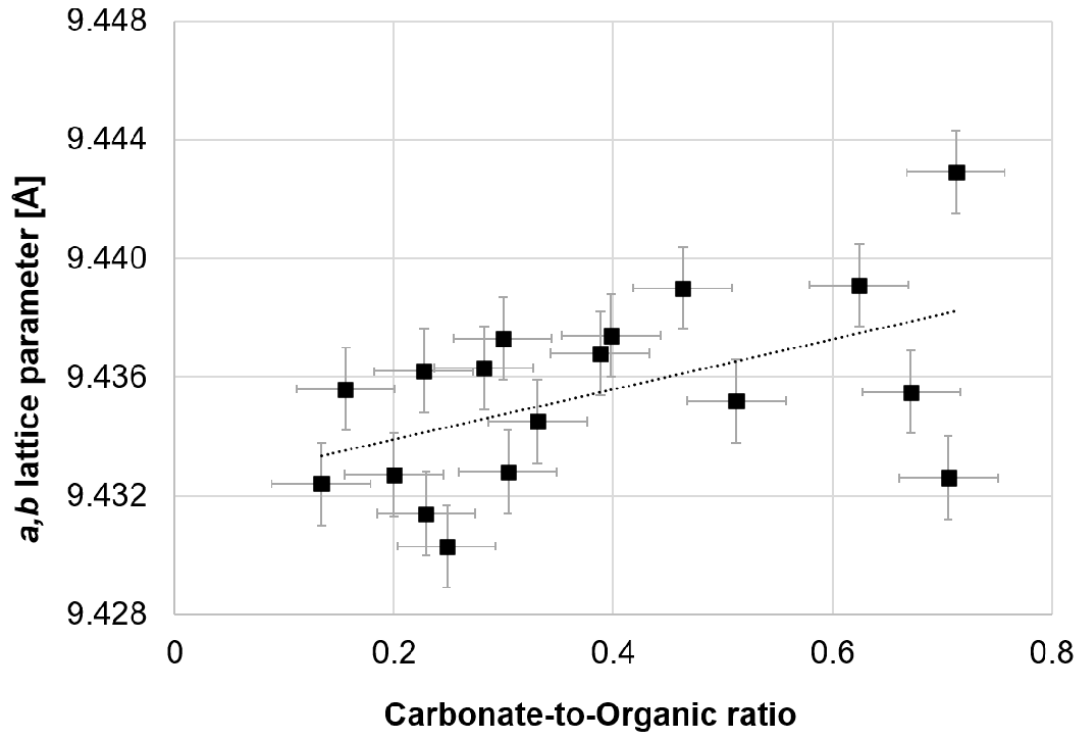
Figure 7. The carbonate-to-organic ratio of adult human bone bioapatite as determined by peak fitting of ATR-FTIR spectra appears to trend with respect to the a , b lattice parameter derived from Rietveld refinement of X-ray powder diffraction data.